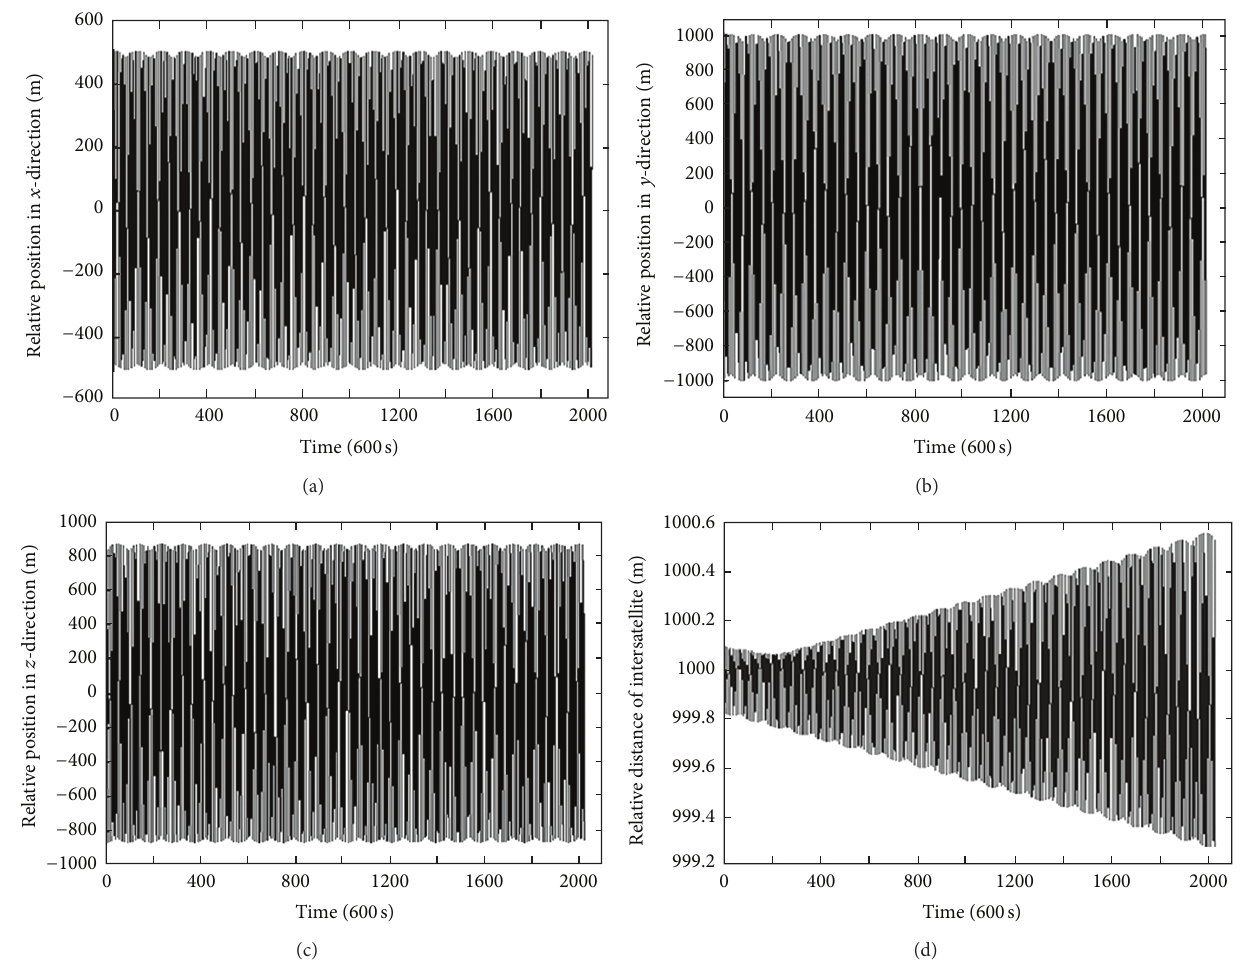
Figure 2: Simulation results of the first subordinate satellite.